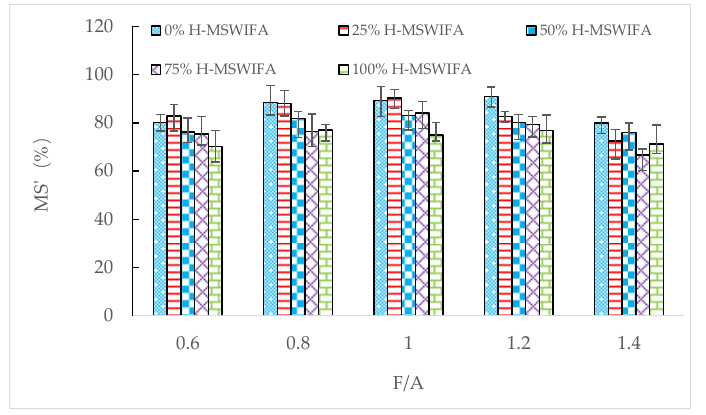
Figure 14. The MS’ of AC-13.